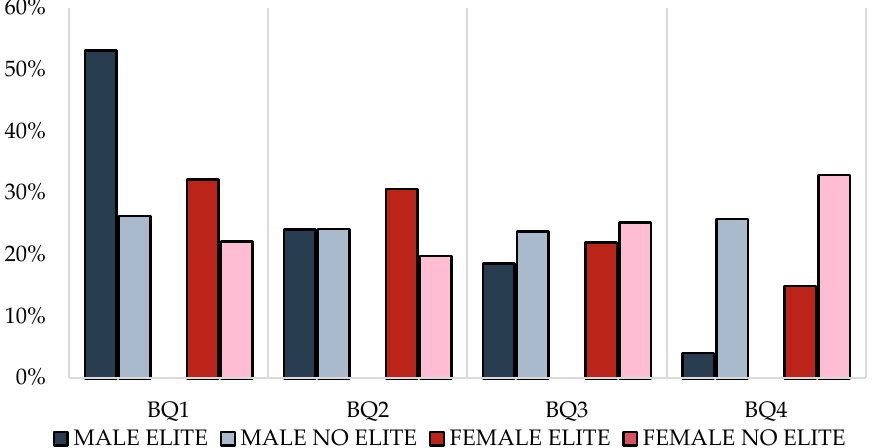
Figure 1. Relative age effect in male teams: BQ1—first quartile; BQ2—second quartile; BQ3—third quartile; BQ4—fourth quartile.